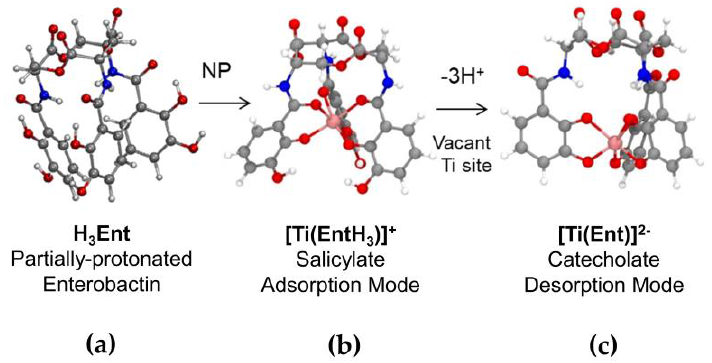
Figure 6. Surface solubilization mechanism of the TiO 2 -NPs by enterobactin. The mechanism consists of ( a ) the approach of a partially protonated enterobactin near neutral pH toward the TiO 2 NP surface; ( b ) the binding to a Ti site in the salicylate mode via one or two bidentate catechols group(s) first, and then its full chelation; and ( c ) the rate-limiting detachment of the Ti atom, leading to the release of a catecholate Ti- ent complex (1:1 stoichiometry) in the environment, followed by a proton-exchange reaction with the vacant site to regenerate the surface.